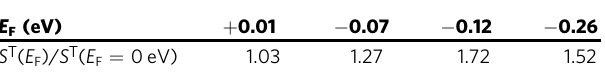
Table 1 Ratios between the theoretical Drude weights S T ( E F ) calculated with the different Fermi energies and the theoretical Drude weight S T ( E F = 0